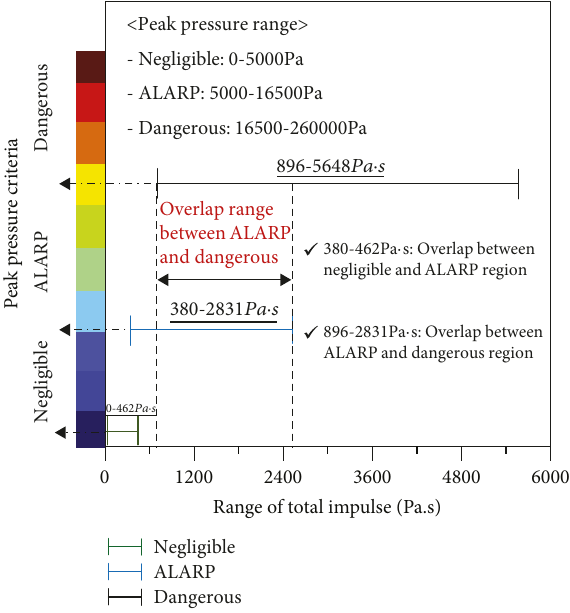
Figure 11: Impulse range based on the peak pressure